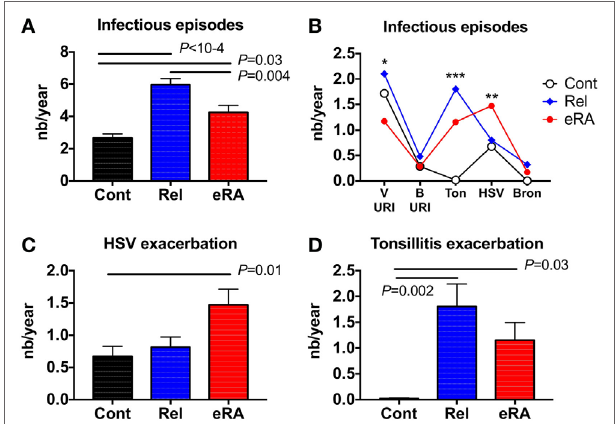
FigUre 1 | The number (nb) of infectious symptom events during the 1-year period preceding the arthritis onset (early [e]RA) or the first examination [healthy control (Cont) and first degree relatives (Rel)]. The following parameters were assessed: viral upper respiratory tract infection symptoms (V-URI), bacterial upper respiratory tract infection symptoms requiring antibiotic therapy (B-URI), acute bronchitis, herpes simplex virus (HSV) exacerbation/reactivation, and chronic tonsillitis exacerbation. (a) Total infectious symptom event incidence in the preceding year; (b) specific infectious symptom incidence history; (c) HSV exacerbation/reactivation; and (D) chronic tonsillitis exacerbation. Statistics are indicated when P ≤ 0.05 and (*) denotes the calculated P- values * P ≤ 0.05, ** P ≤ 0.01, *** P ≤